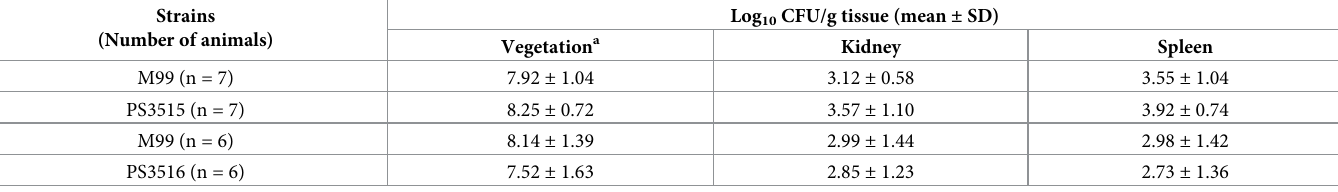
Table 1. Competition model of endocarditis in rats, 72 h